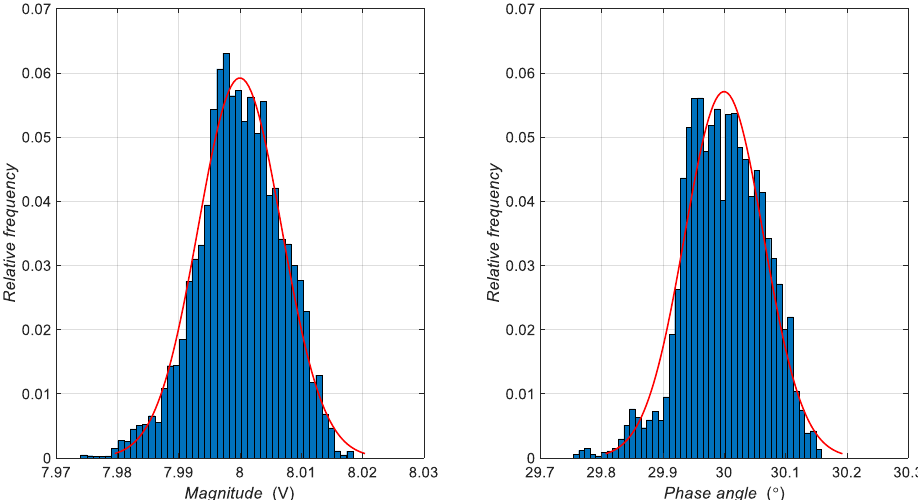
Figure 13. Histogram of 5th harmonic magnitude and phase angle.